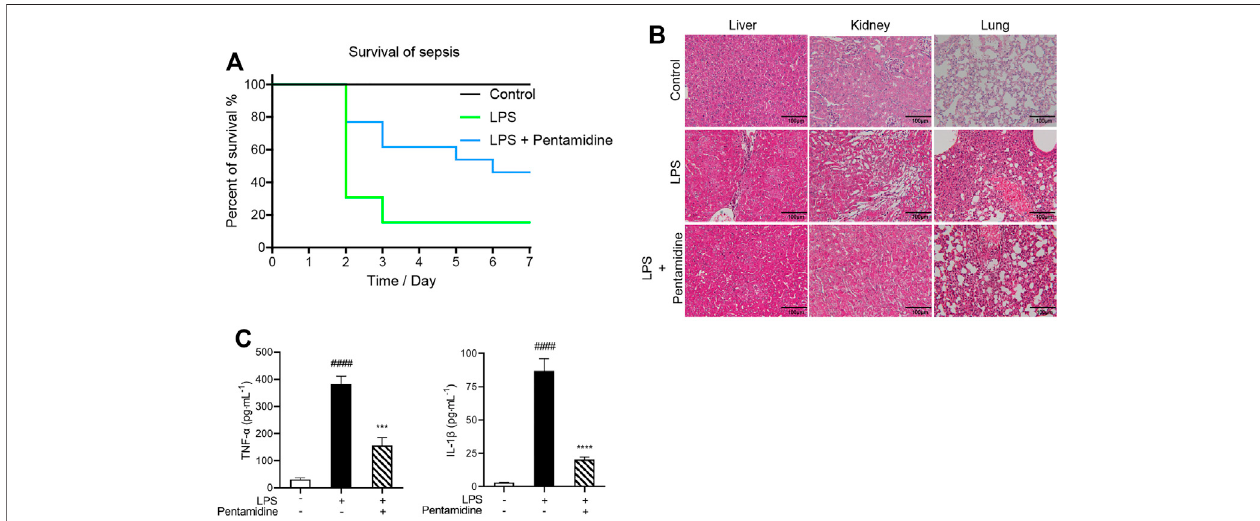
FIGURE 8 | Pentamidine decreases the mortality of septic mice (A) , alleviates LPS-induced damages in liver, kidney, and lung (B) , and reduces LPS-induced systemicin fl ammation (C) . (A) Survivalcurves ofmice underthe indicatedtreatmentswith LPSand pentamidine.Asingle doseofLPS(25 mg/kg, i.p. ; n =12per group) was administered to induce sepsis. Pentamidine (10 mg/kg., i.p. ) was administered for 4 days. The mortality of mice was recorded for consecutive 7 days. (B) A single doseofLPS(25 mg/kg, i.p. ; n =6pergroup)wasadministeredtoinducesepsis.Asingledoseofpentamidine(10 mg/kg, i.p. )wasadministered30 minbeforeLPS injection. After 24 h, mice were euthanized. The LPS induced damages in liver, kidney, and lung were checked by (H&E) staining. Three representative microscopic images were taken. Images were taken at ×400 magni fi cation. (C) The pro-in fl ammatory factors TNF- α and IL-1 β in sera from the mice treated as shown in (B) were measured by ELISA according to the manufacturer ’ s instructions. ####, p < 0.0001 versus the control; ***, p < 0.001 versus the LPS group; ****, p < 0.0001 versus the LPS